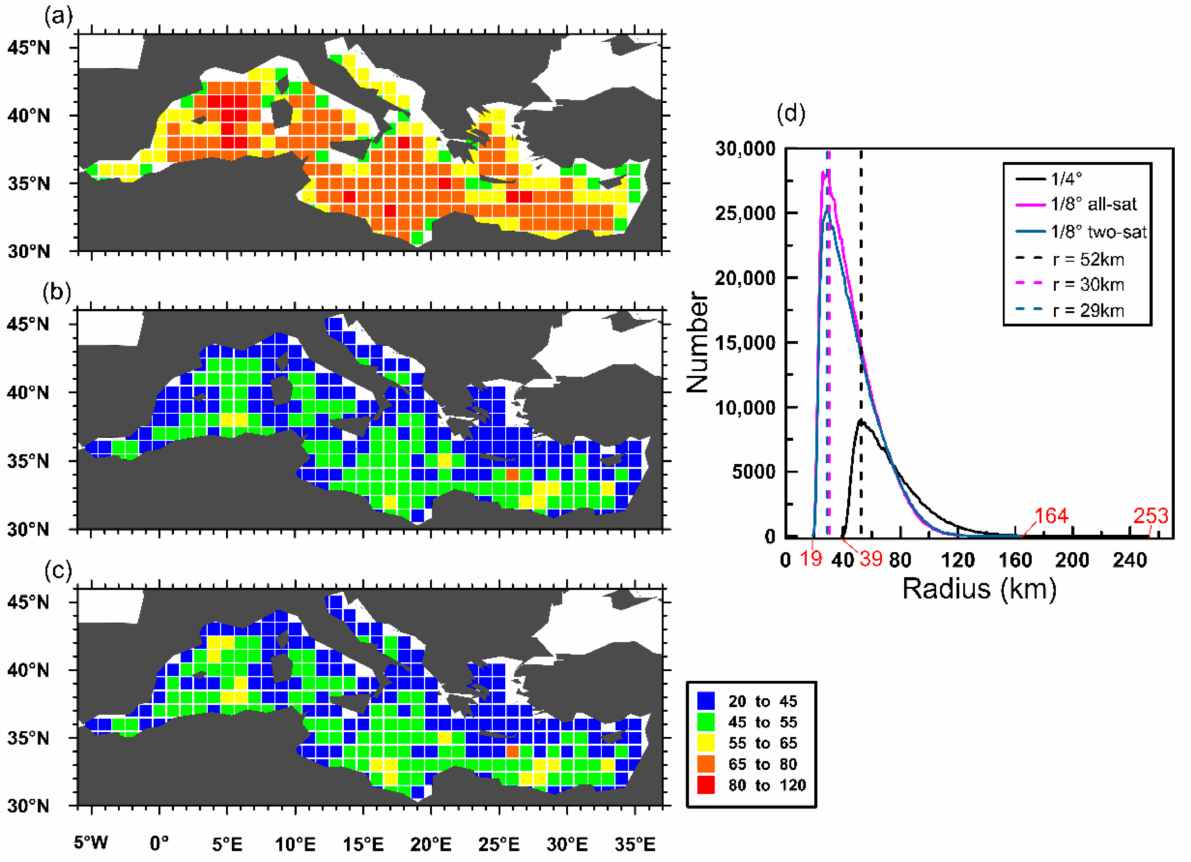
Figure 4. Eddy radius distribution maps and radius histogram of the Mediterranean Sea: ( a ) 1/4 ◦ ; ( b ) 1/8 ◦ all-sat; ( c ) 1/8 ◦ two-sat. The colored squares represent the range of eddy radii, as shown in the legend. The histogram ( d ) represents the relationship between eddy radii and number in the different datasets, where the black line represents the eddies identified using the 1/4 ◦ data, and the magenta (desert blue) line represents eddies identified using the 1/8 ◦ all-sat (two-sat)